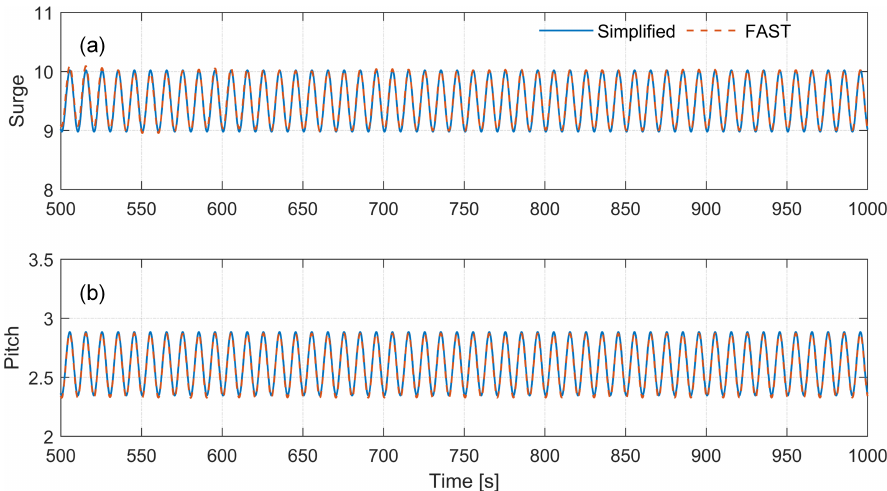
Figure 14. Time response of motion RAO for spar-buoy floater under regular waves: ( a ) Surge; ( b ) Pitch.